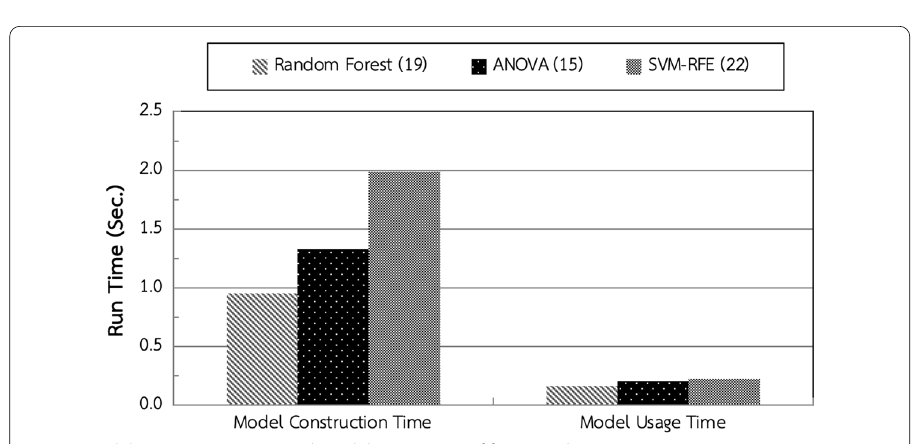
Fig. 7 Model construction time and model usage time of feature